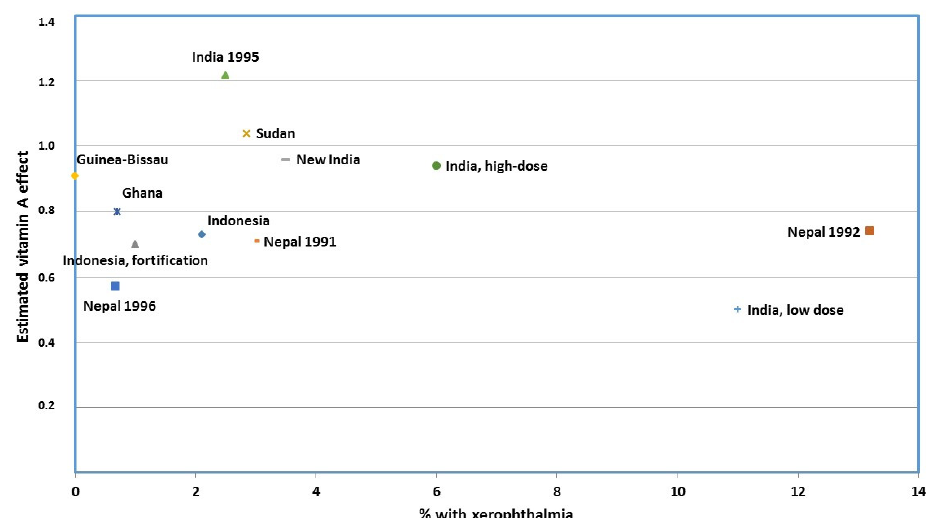
Figure 1. The relative risk comparing vitamin A vs. no vitamin A by prevalence of xerophthalmia in the original eight [2], the two subsequent [8,9], and the two new trials [10,11] of vitamin A supplementation to children above 6 months of age (Modified by Beaton et al., 1993 [2], and first presented in Benn et al., Int. J. Epidemiol . 2015 [7]).